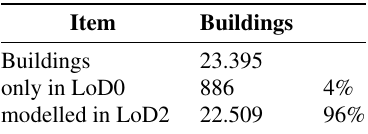
Table 1. Input building stock in Rijssen-Holten